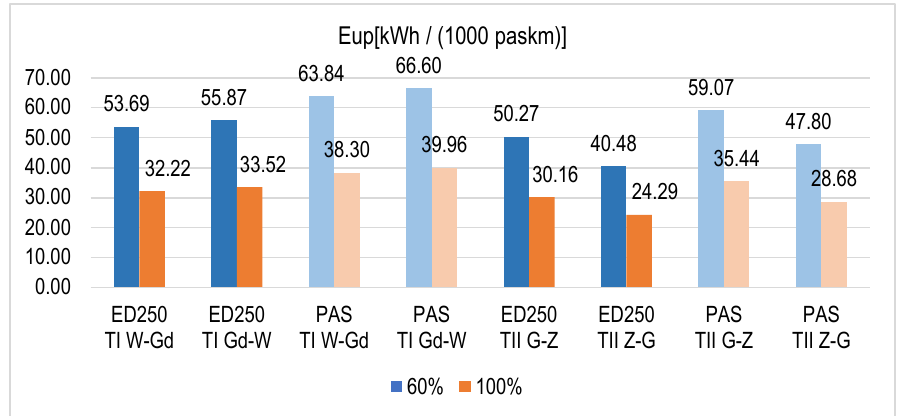
Figure 13. Comparison of specific energy consumption for traction. Source: developed by the authors. A comparison of energy consumption, with 100% and 60% seats in the train occupied, indicates that the ED250 train is more environmentally friendly. On both routes and in both directions, there is a difference, on the TI route about 10 kWh/(1000 pas km) with 60% and about 6 kWh/(1000 paskm) with 100% occupied seats, and on the TII route when the train is 60% occupied: 9 kWh/(1000 paskm) in the direction of Grodzisk–Zawiercie and 7 kWh/(1000 paskm) in the direction Zawiercie–Grodzisk. Figure 14 shows a comparison of the energy consumption for the ED250 and PAS train, which is resulted from higher motion resistances R of PAS train (Figure 6) when compared with the ED250 train (Figure 4) and, respectively, higher current taken by the PAS train taken during travel (Figure 12b) comparing with the ED250 train (Figure 12a).